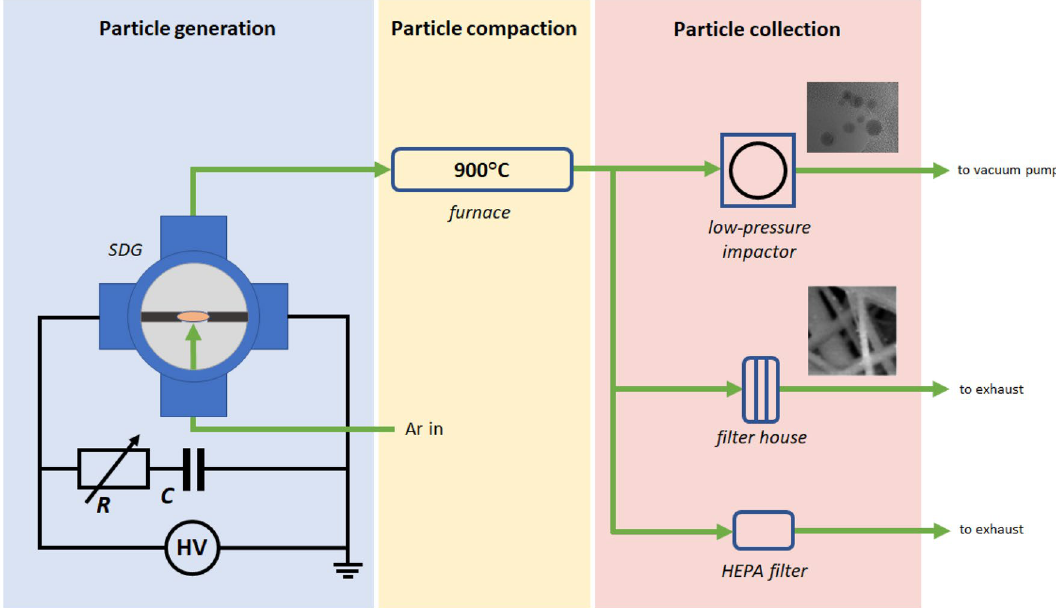
Figure 1. Schematic figure of the particle generation, collection, and sampling